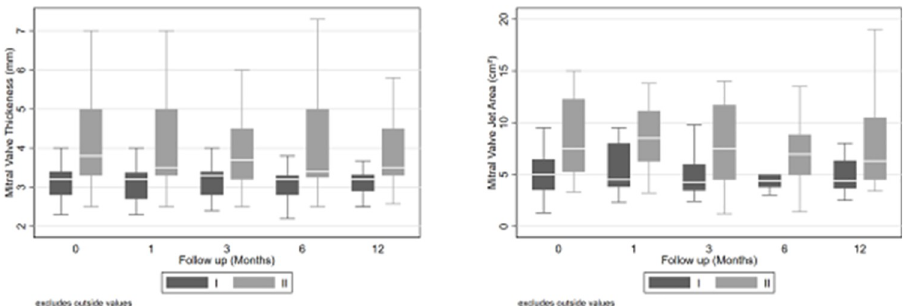
Fig 2. Box-plots of mitral valve leaflets thickness (A) and mitral regurgitant jet area (B) at baseline examination (0) and during the first follow-up year showing that abnormal changes identified at baseline in Groups I (not developed RHD) and II (who developed RHD) persisted during the first year after the ARF